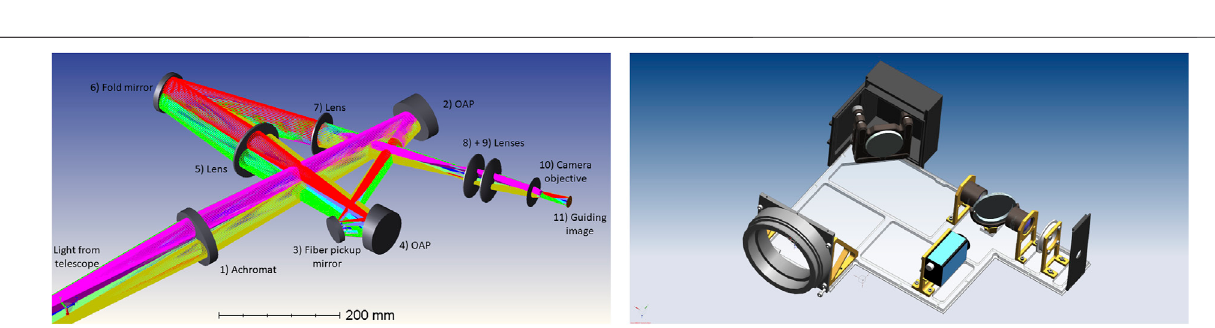
FIGURE 9 | Left: Mid-resolution resolved Sun fi ber setup for the VVT: The full image of the Sun is re-imaged onto the fi ber pickup mirror that is hosting a 525 μ m fi ber(correspondingtoa32arcsec fi eldofview).The fi berleadstoaFourier-Transform-spectrograph.Behindthepickupmirrorthelightisagainre-imaged,thistimeonto theguiding camerawhichisusedbypyobsforbothpointing andguiding.Right:CAD-modelofthe fi ber-guidingunitforthe50 cmtelescope.Starlightisre-imagedonto a fi ber-pickup mirror and the remaining light is redirected into the guiding camera, allowing for nearby stars to act as